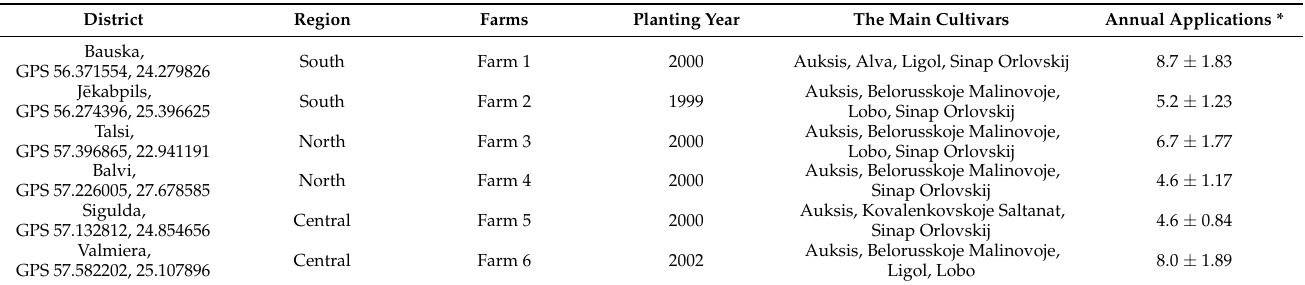
Table 1. Location and characteristics of apple orchards used in this